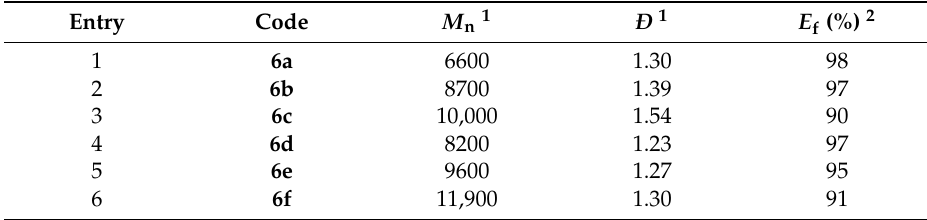
Figure 2. 1 H NMR spectra (DMSO- d 6 , 400 MHz) of the copolymers collected at different reaction stages: ( a ) 4b , ( b ) 5b , ( c ) 6b , and ( d ) 7b . Table 2. SEC characterization results of the copolymer 6.